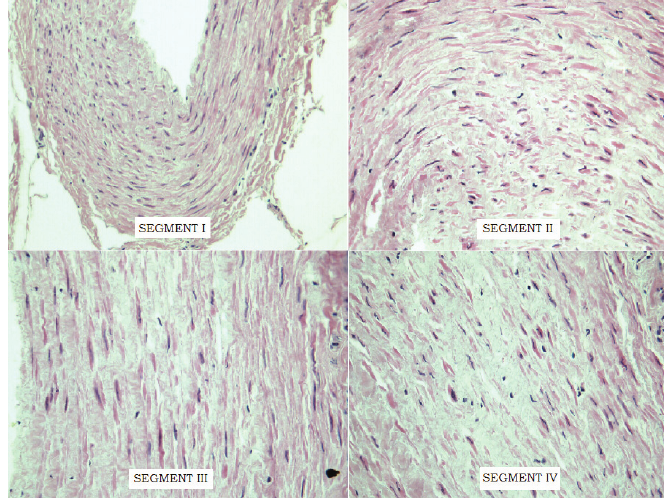
FIGuRE 3 – Endovascular electric power energy liberated for five seconds inside each venous segment studied.